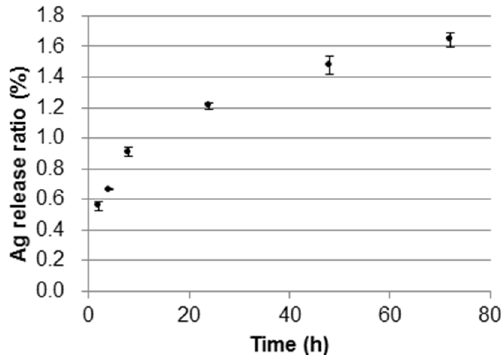
Figure 5. Ag(I) ions release profiles for the DNA/Ag nanoparticle immobilized cotton fabric (34,000 ppm as Ag). Error bars represent maximum and minimum value ( n =